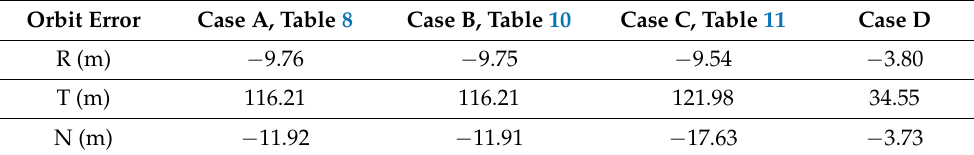
Table 9. Post-fit orbit errors of Rosetta S/C, for the four cases considered in Section 4.4, along the Radial, Transverse (along-track) and Normal (cross-track) directions, with respect to the orbit determined by ESOC, in the J2000 comet-centered frame. These errors are almost constant during the 22 min CONSERT observation window. Case A is relative to Table 8, case B is relative to Table 10, case C is relative to Table 11, and case D is relative to the fixed GM value (last case of Section 4.4).